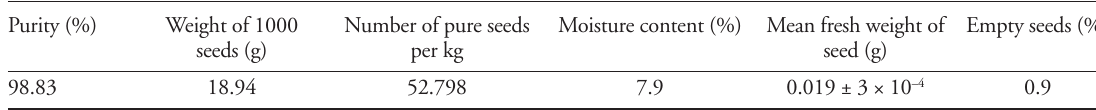
Table 1. Seed quality characteristics. Values given in the table represent means, n = 2500 seed units. Purity (%) Weight of 1000 Number of pure seeds Moisture content (%) Mean fresh weight of seeds (g) per kg